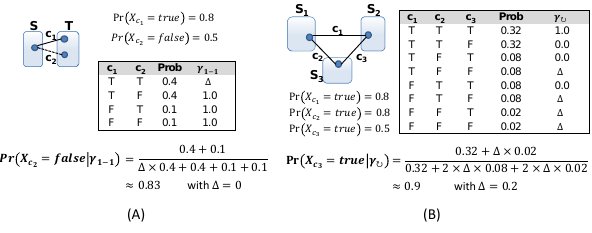
Figure 4. Compute conditional probability with (A) 1-1 constraint and (B) cycle